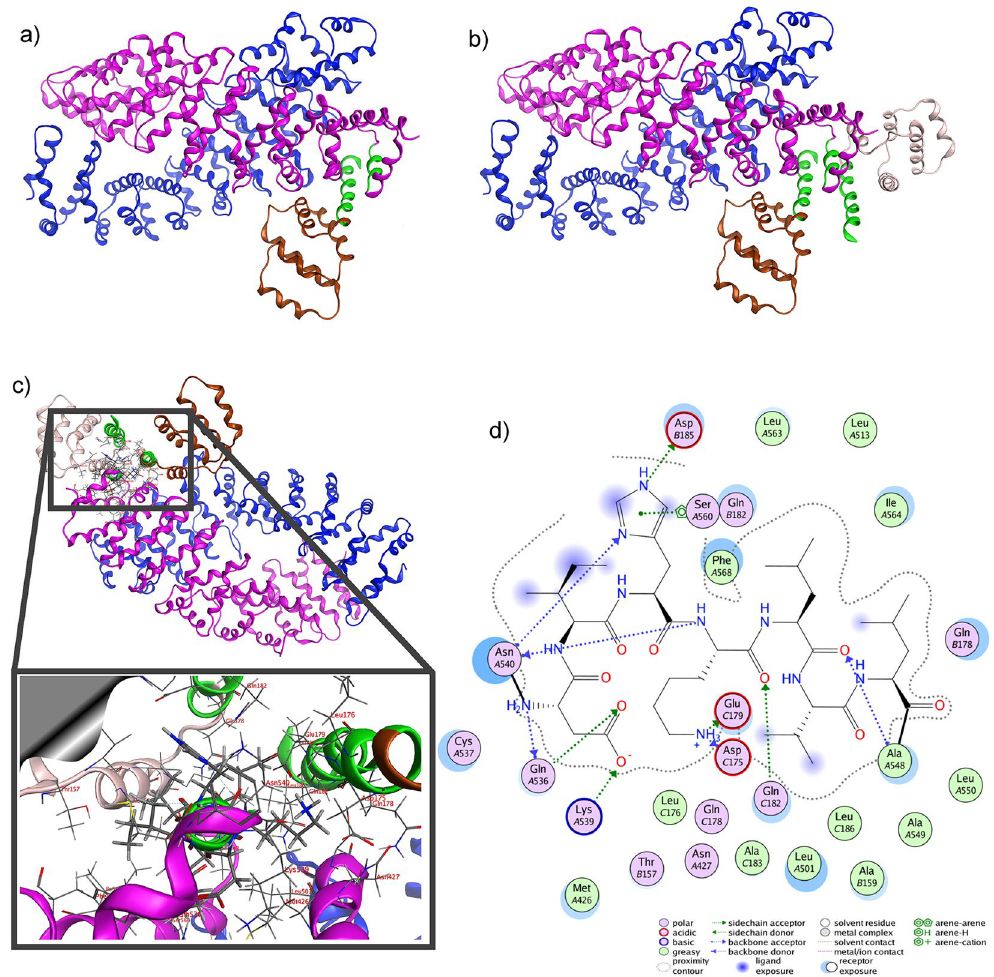
Figure 5. Molecular docking of LRRK2 ARM to FADD-DD. The model of dimeric LRRK2 ARM was used to dock the FADD DD crystal structure. The docking was performed iteratively placing each FADD DD structure onto the LRRK2 ARM model in sequence. ( a ) The FADD DD crystal structure (brown ribbon) was docked onto the LRRK2 dimer model (shown in blue and magenta ribbon, as before). ( b ) A second copy of the FADD DD crystal structure (silver ribbon) was docked to the molecular complex established in the previous step ( a ). The interaction was achieved via a network of antiparallel α -helical bundles (shown in green ribbon representation). ( c ) The network of molecular interactions between the specific residues involved is highlighted (inset). ( d ) The association between LRRK2 and FADD DD is stabilized via a mixture of ionic/hydrogen bonds, π -stacking and hydrophobic interactions. The amino acid notations are as follows: A , refers to the LRRK2 ARM sequence; and B, C refer to each FADD DD